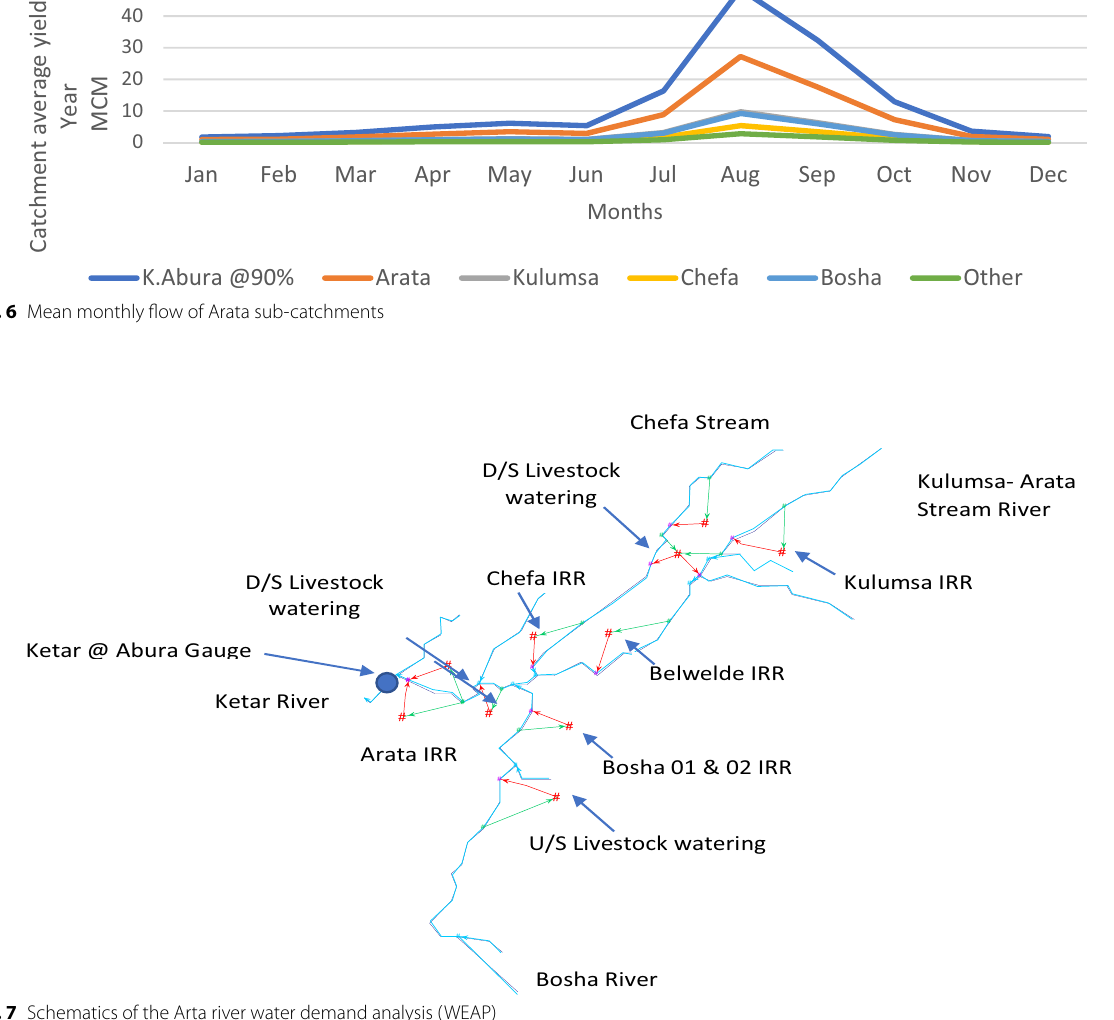
Fig. 7 Schematics of the Arta river water demand analysis